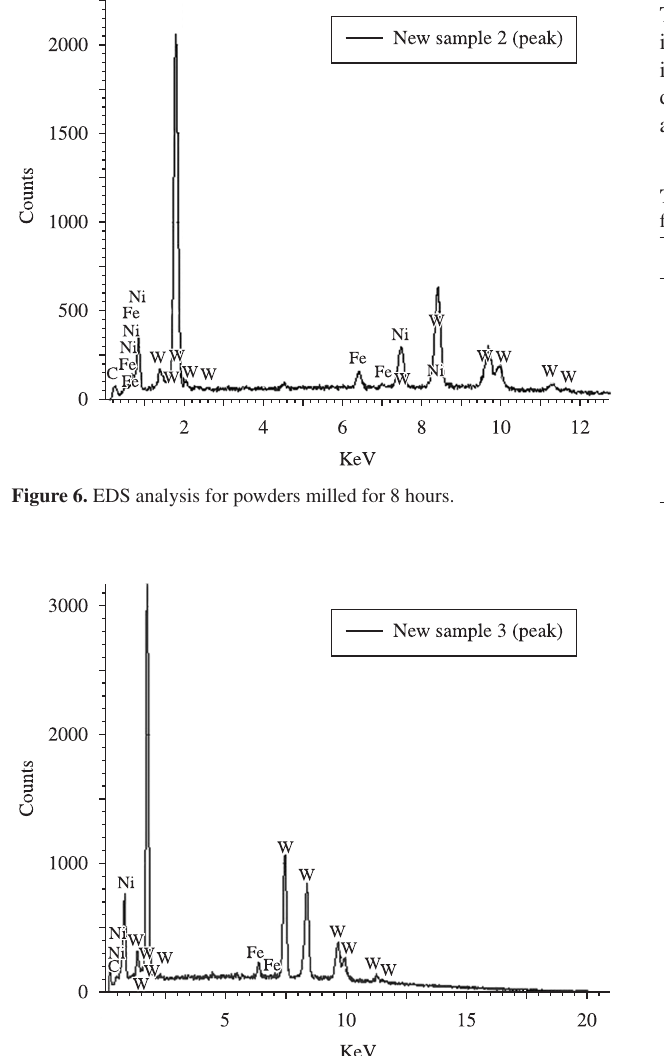
Figure 9. EDS analysis for powders milled for 64 hours.